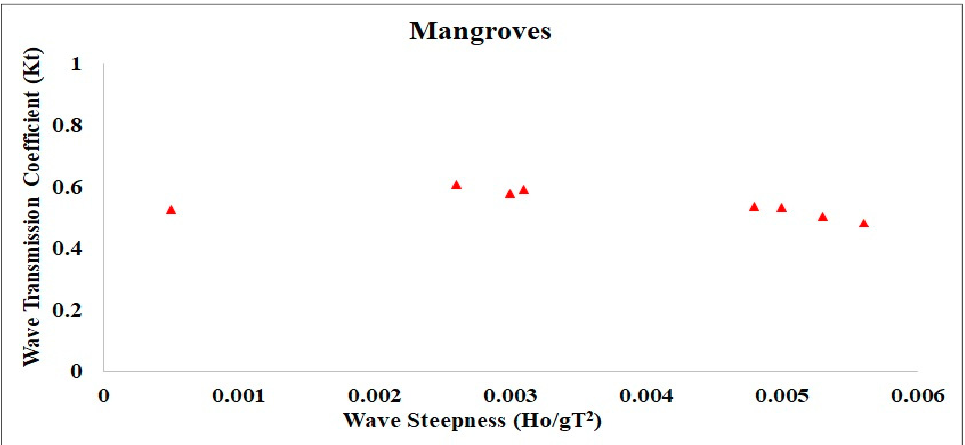
Figure 3. Plot between the wave transmission coefficient and wave steepness for mangroves structure (adapted from Yuanita et al.) [35].